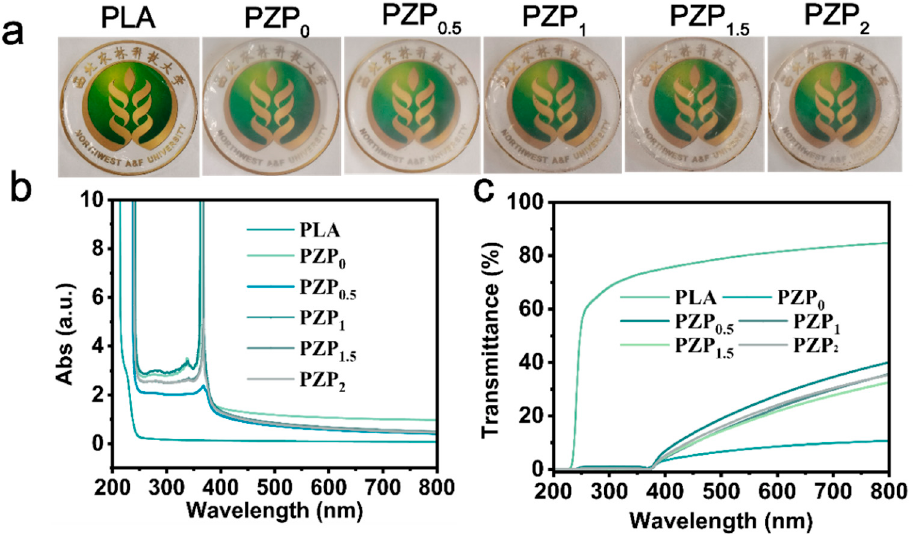
Figure 3. ( a ) Photographs of PLA-based composite films, ( b ) UV–vis light transmittance, ( c ) ab- sorbance spectra of PLA based composite